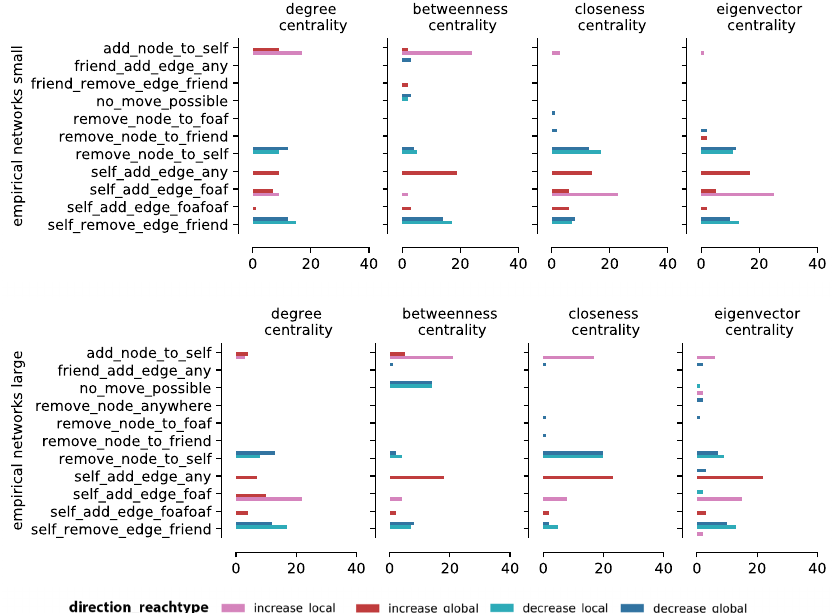
Figure 6. Optimal move counts per centrality measure for small and large empirical network data sets. The top graphs show the frequency of the optimal move counts for small empirical networks and the bottom graphs show the frequency of the optimal move counts for large empirical networks. The x -axis shows the frequency counts for the optimal moves, and the y -axis shows the different optimal